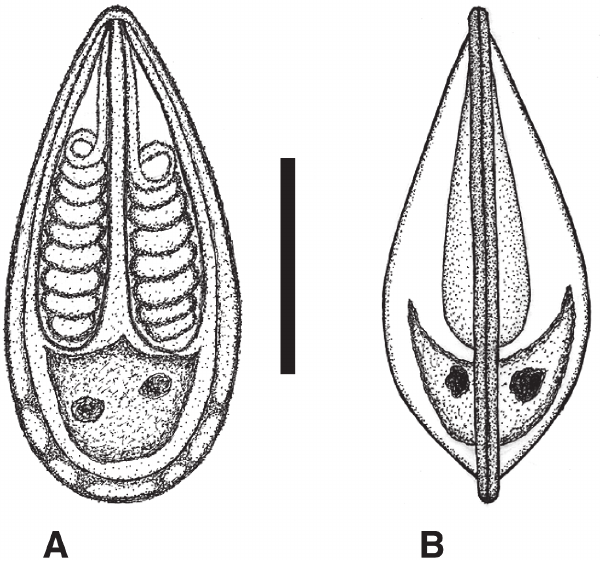
Fig. 5. – Schematic representation of mature spores of Myxobolus cuneus n. sp. A - frontal view. B - lateral view. Scale bar = 5